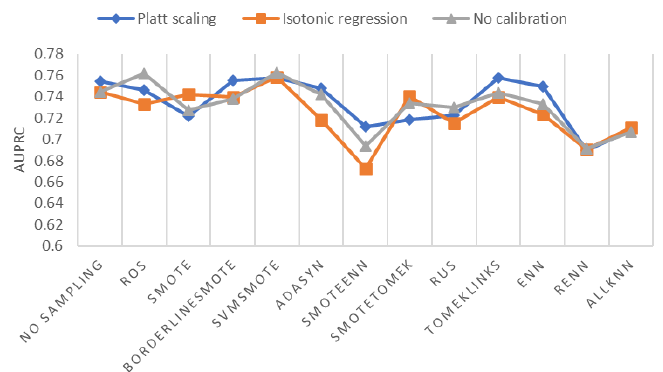
Figure 8. AUPRC of different sampling methods and probability calibration methods.